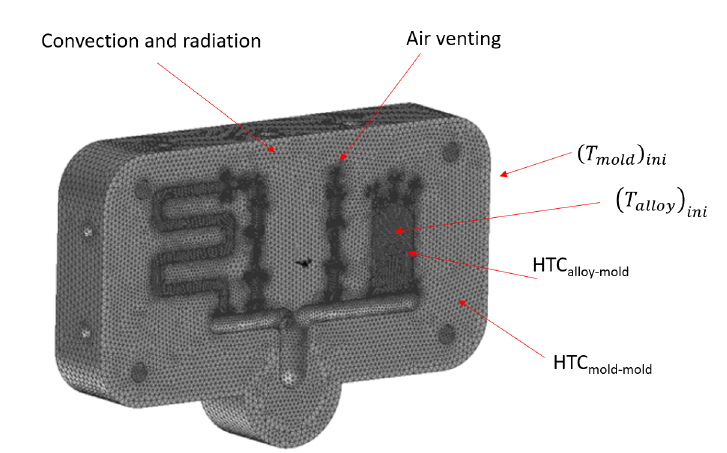
Figure 9. Schema of some of the boundary